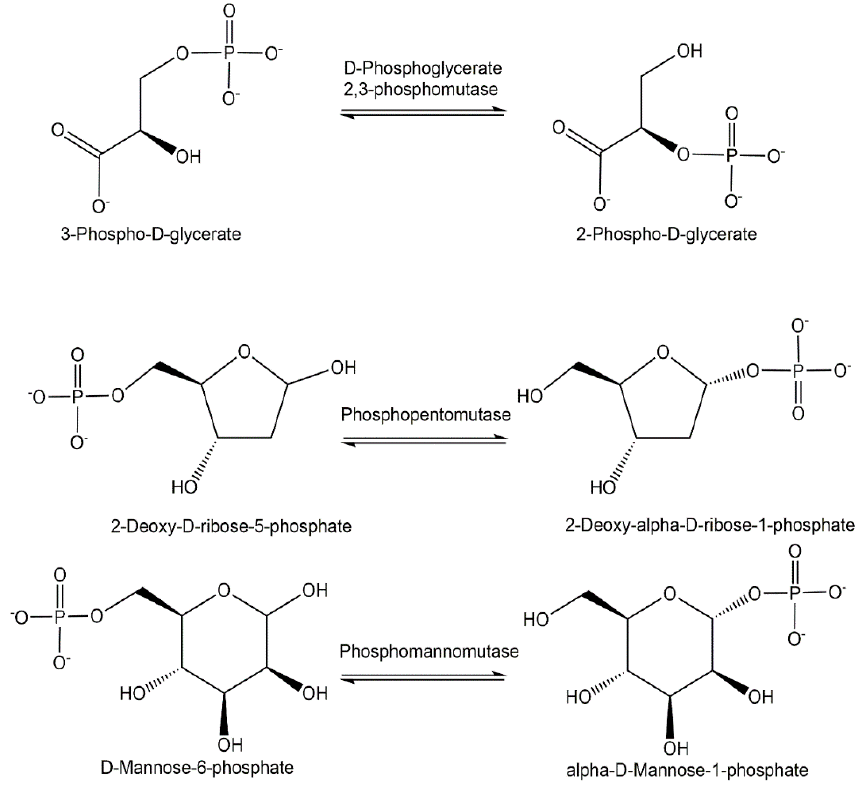
Figure 6. Selected phosphomutases for intramolecular phosphorylation reactions. While D-glucose 6-phosphate interconversion catalyzed by α -D-phospho-glucomutases leads to α -D-glucose 1-phosphate [93], β -D-glucose 1-phosphate is obtained when its interconversion is catalyzed by β -D-phosphoglucomutases [94] in the thermody- namically unfavorable rearrangement of phosphoenolpyruvate to 3-phosphonopyruvate catalyzed by phosphoenolpyruvate mutase [95].